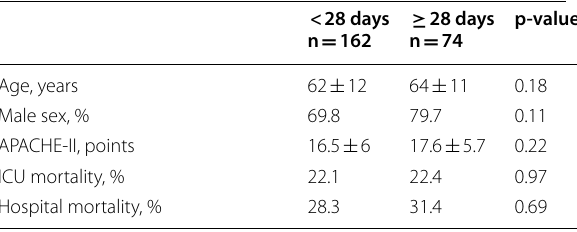
Table 1. Clinical characteristics of the patients with short and long stay